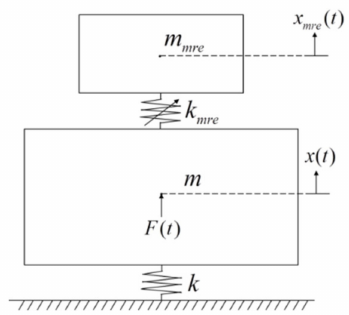
Figure 8. Modeling of adaptive tuned vibration absorber and primary structure.